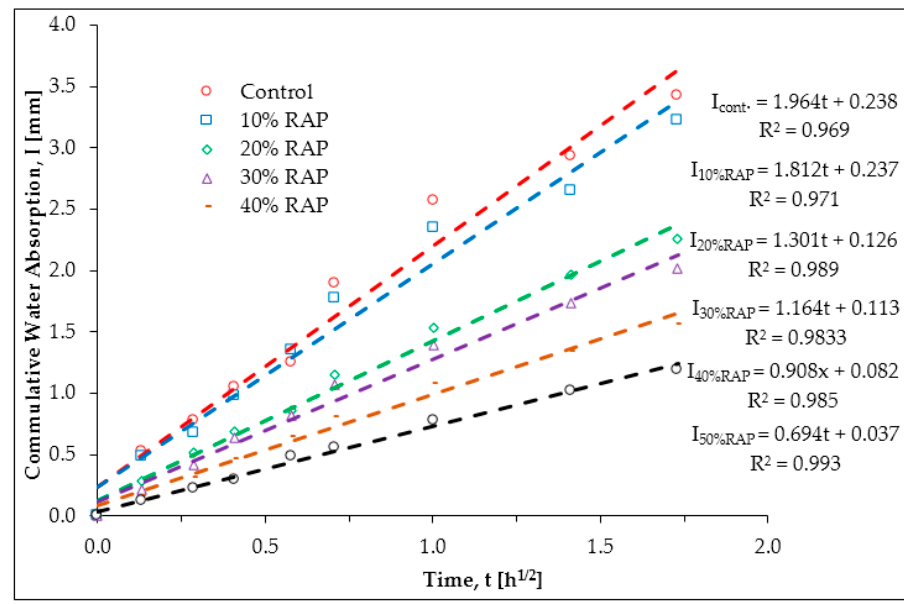
Figure A2. Cumulative water absorption by RAP Concrete.